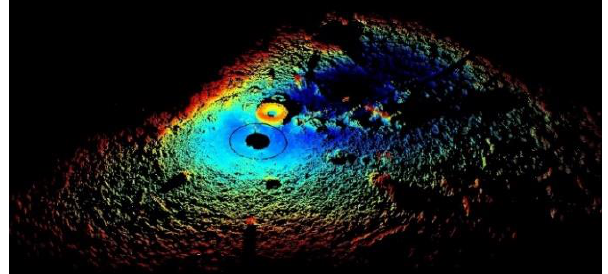
Figure 6. 3D results after choosing the ROI.